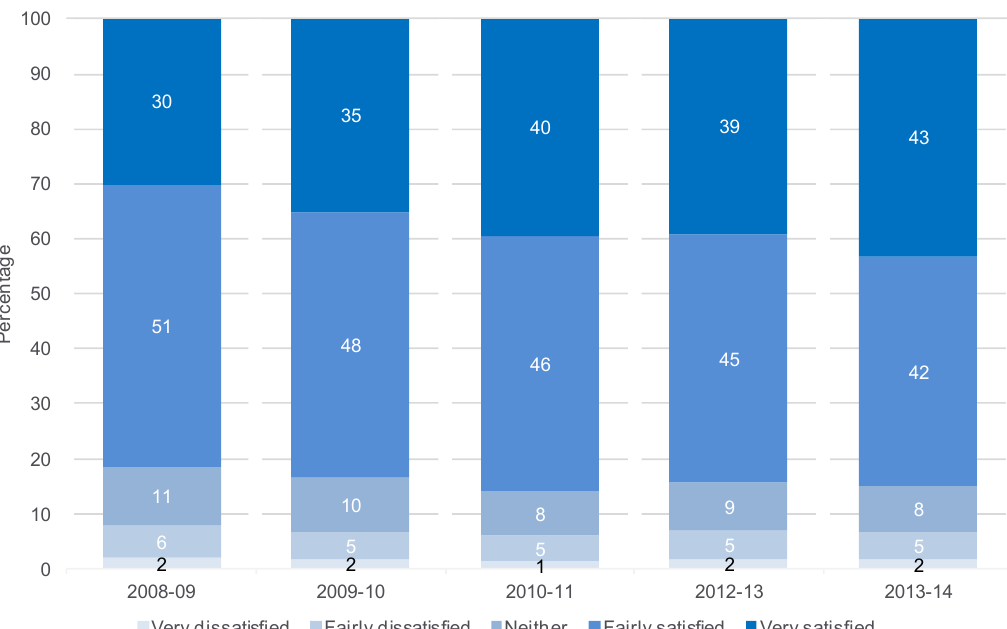
Figure 15: Proportion of people who are satisfied with their local area as a place to live, 2008-09 to